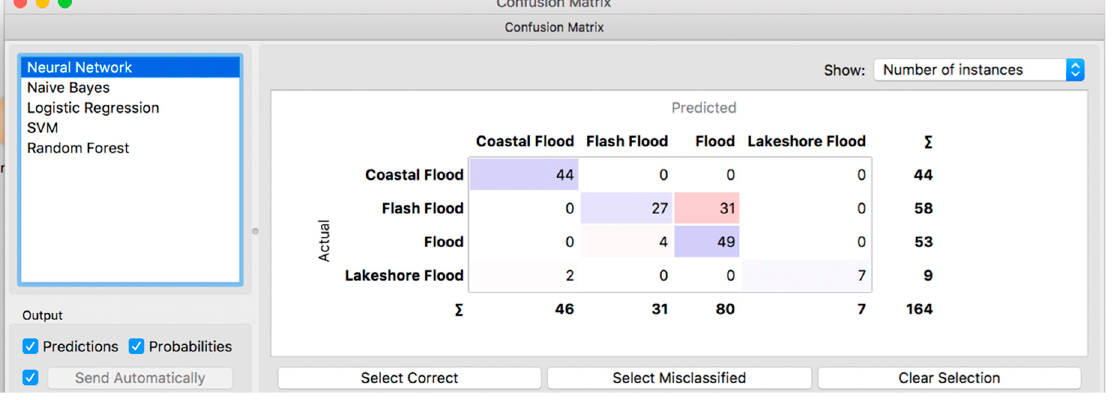
Figure 10. Evaluation Results for Neural Network model in Orange.